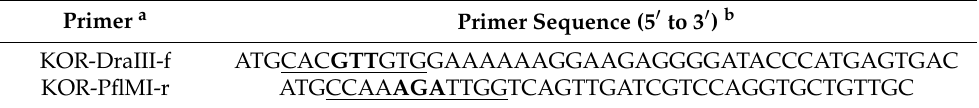
Table 1. The primers used to construct the expression plasmid by Ordered Gene Assembly in Bacillus subtilis (OGAB) method.